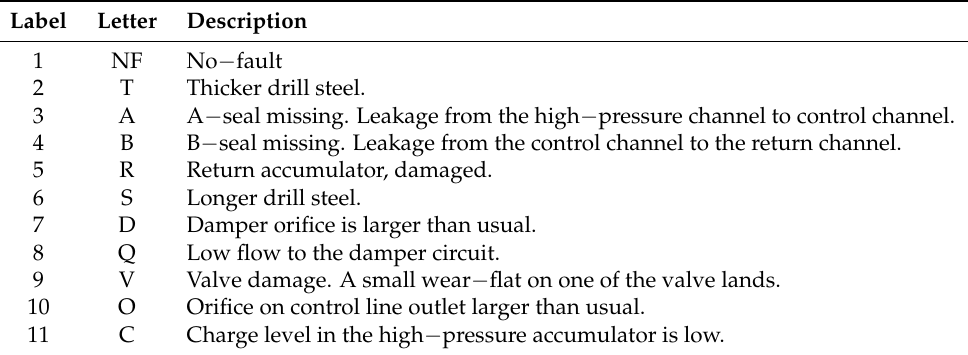
Table 2. Descriptions of fault classes and the NF class for a hydraulic rock drill.